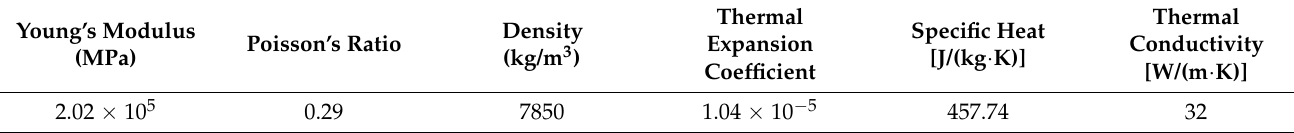
Table 2. Material properties of brake disc.